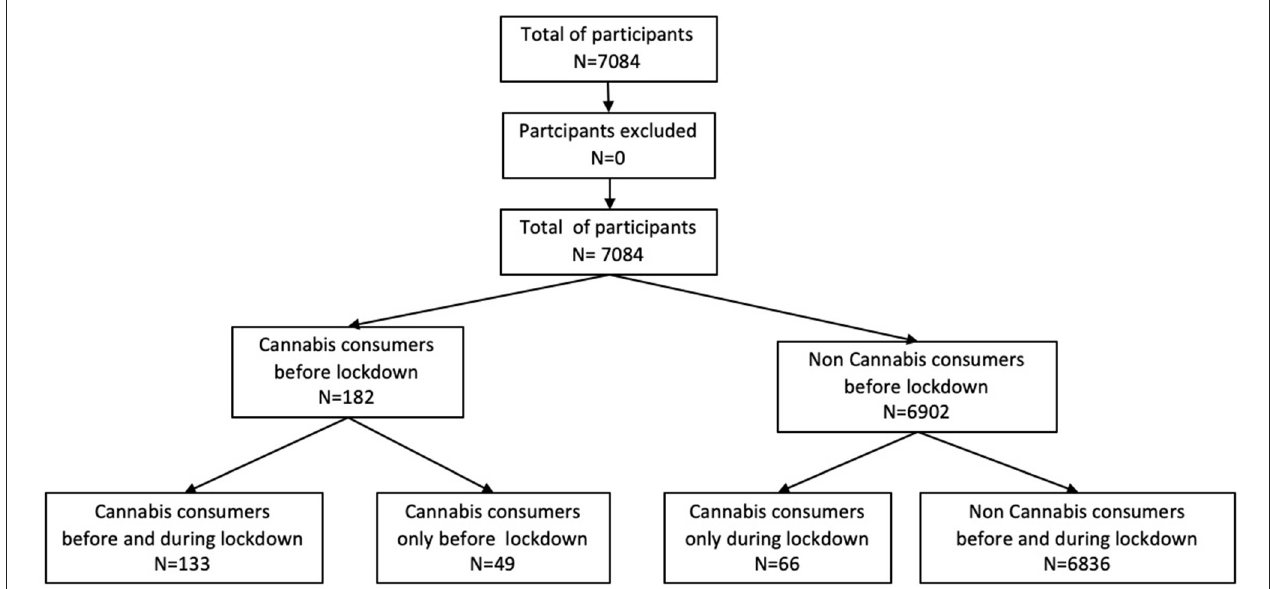
FIGURE 1 | Flow chart on the recruitment of